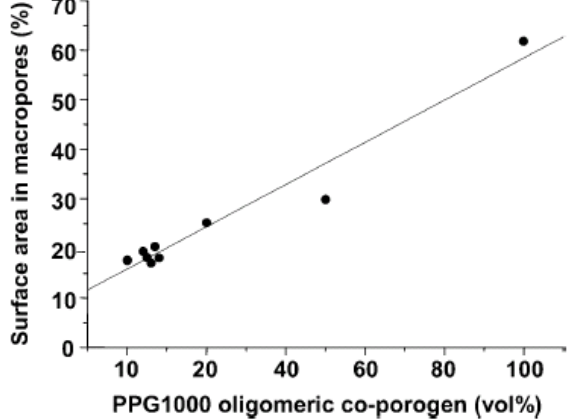
Figure 5. Plot of the surface area of macropores (%) vs. PPG-1000 co-porogen content (vol %) in the dry state for poly(DVB) resins. (Reprinted (adapted) with permission from [18]. Copyright 2004 American Chemical Society).